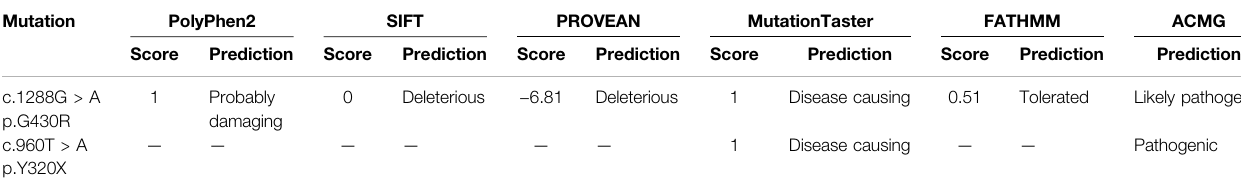
TABLE 2 | Bioinformatics analysis of the TFR2 mutations. Mutation